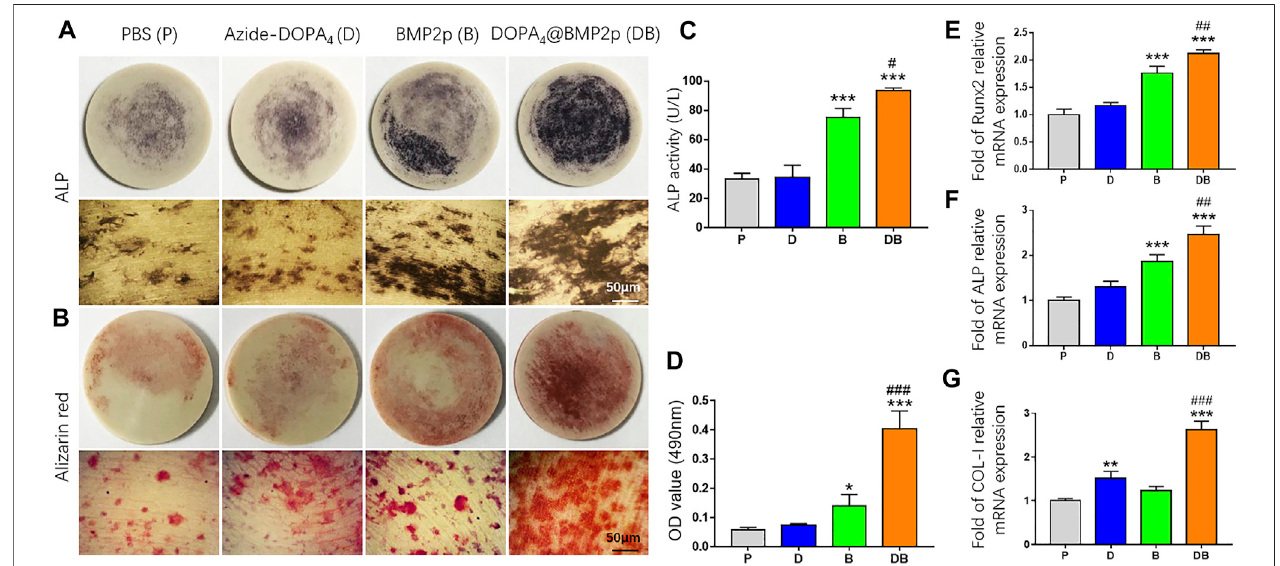
FIGURE 4 | In vitro osteogenesis induction capability of PEEK after different surface modi fi cations. (A) Representative images of ALP staining of rBMSCs on differentPEEKsubstratesafter7 daysofcultureintheosteogenicinductionmedium(upper:generalphotoofwholePEEKandlower:imagesunderthemicroscope). (B) Representative images of Alizarin red S staining after 14 days of osteogenic differentiation (upper: general photo of whole PEEK and lower: images under the microscope). (C,D) Quantitative analysisofALP activity and Alizarin red – stainedmineral layer. (E – G) QPCR analysis ofosteogenic differentiation genes ofrBMSCs ondifferentPEEKsubstratesafter5 daysofcultureintheosteogenicinductionmedium.Statisticallysigni fi cantdifferencesareindicatedby* p < 0.05,** p < 0.01,or*** p < 0.001comparedwiththePBS-PEEKgroup(P)and # p < 0.05and ### p < 0.001comparedwiththeBMP2p-PEEKgroup(B).Abbreviations:P(PBS),D(Azide-DOPA 4 ),B (BMP2p), and DB (DOPA 4